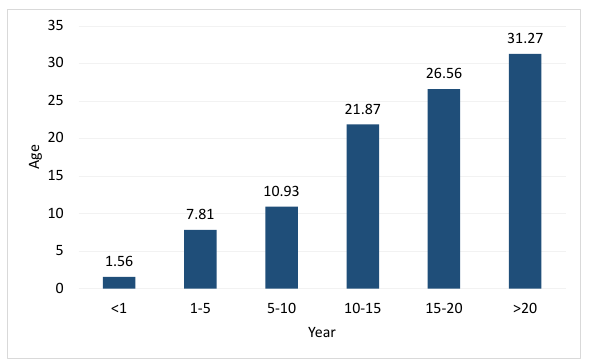
Table 1. Serum lead level for patients Lead level (mg/dL)